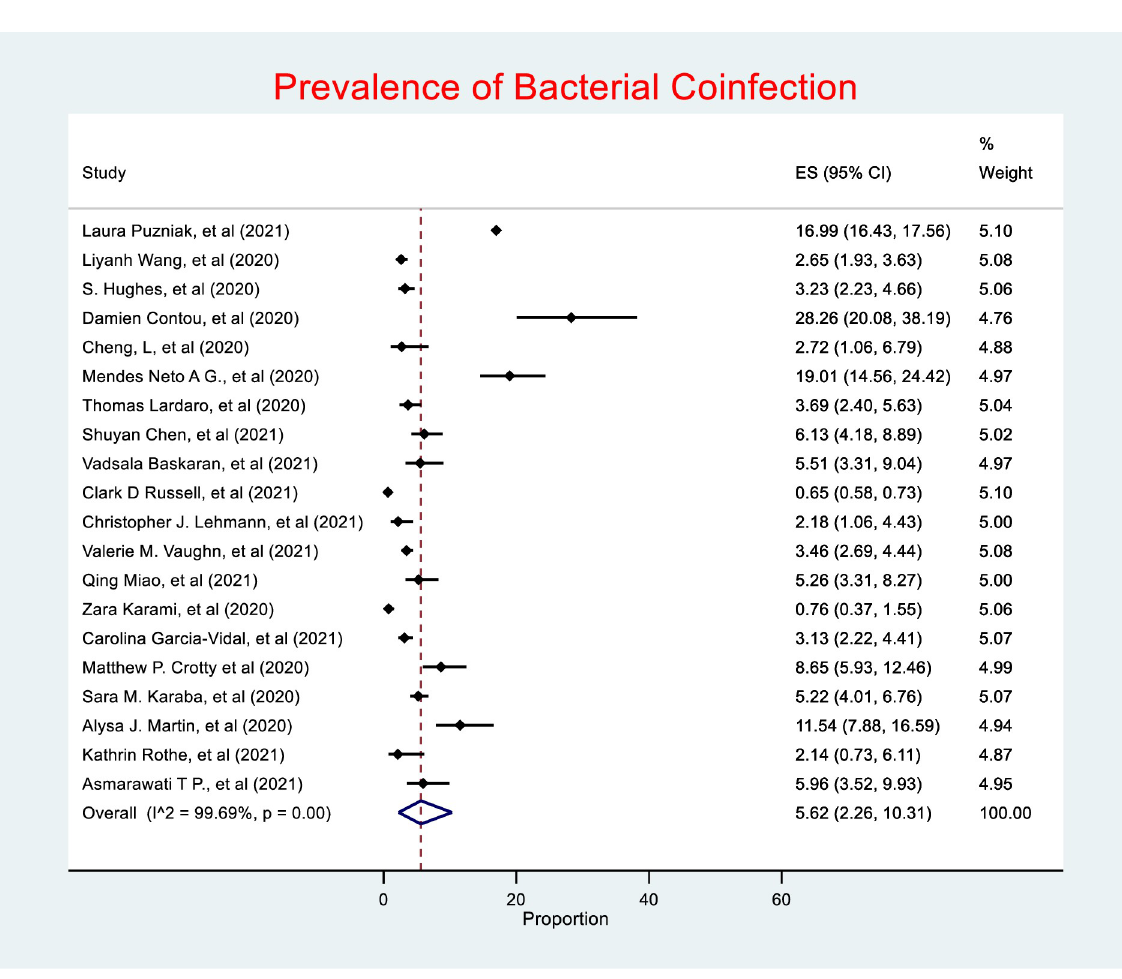
Fig 2. Prevalence of bacterial coinfection. (ES (effect size), 95% CI (95% confidence interval)).